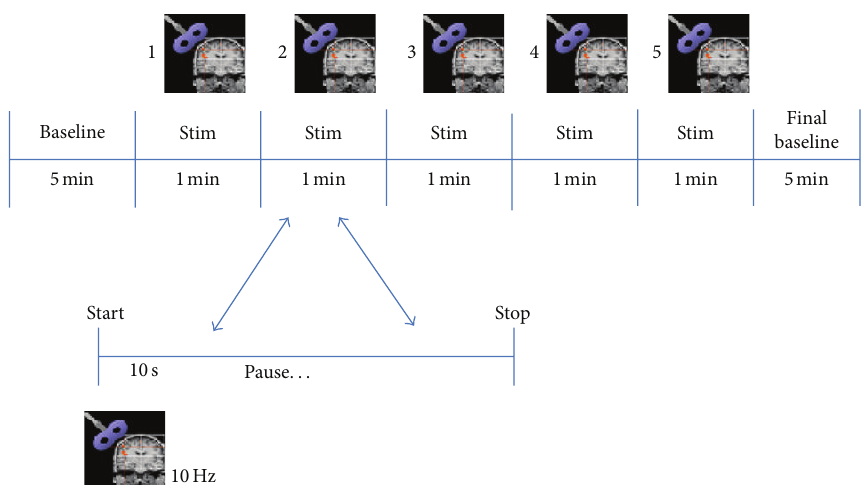
Figure 2: rTMS protocol implemented for all subjects. Note that 5 stimuli were applied during intervals of 1 minute of duration.